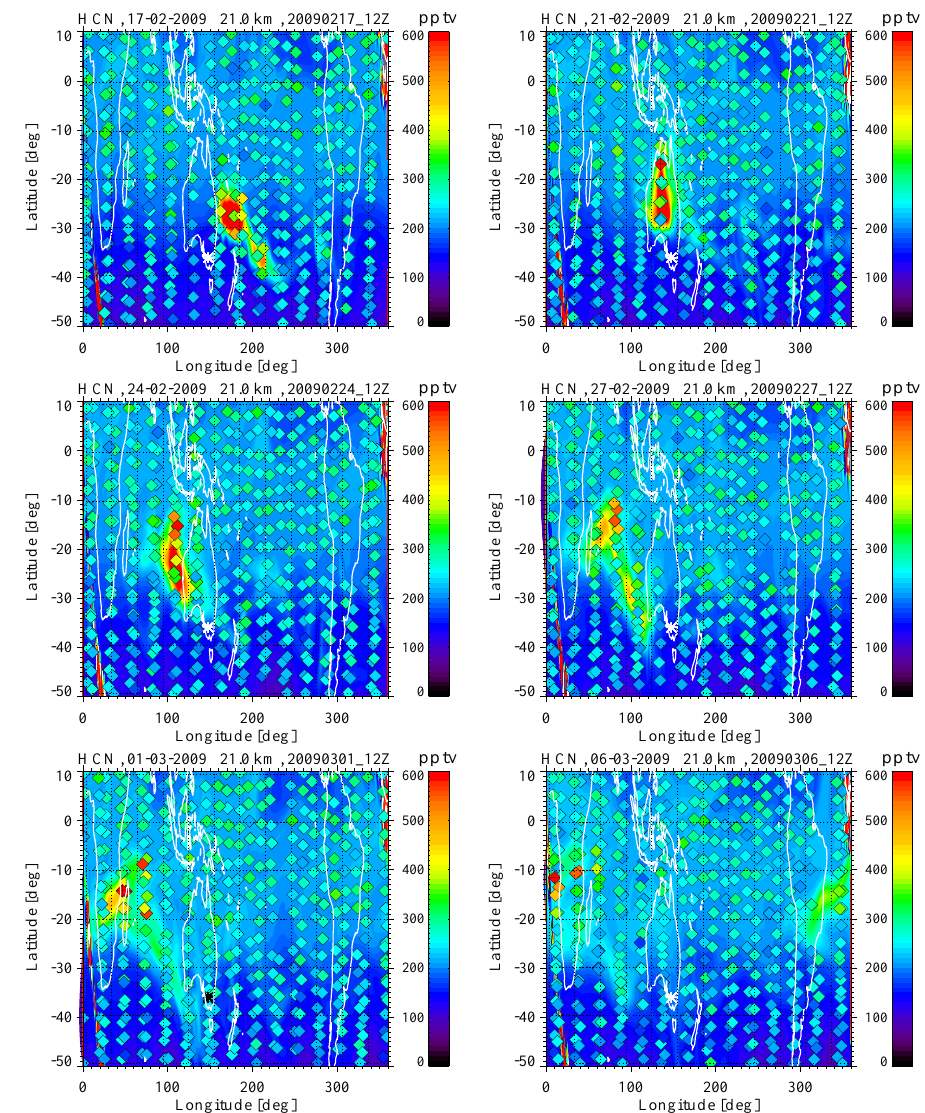
Fig. 14. MIPAS HCN data (diamonds) at 21km altitude, measured on 17, 21, 24, 27 February and on 1 and 6 March 2009. Background areas are GEM-AQ HCN model distributions for 12:00UT of the respective days. Model distributions are smoothed vertically and along-track to MIPAS resolution. Red diamonds with black pluses inside indicate MIPAS VMRs higher than